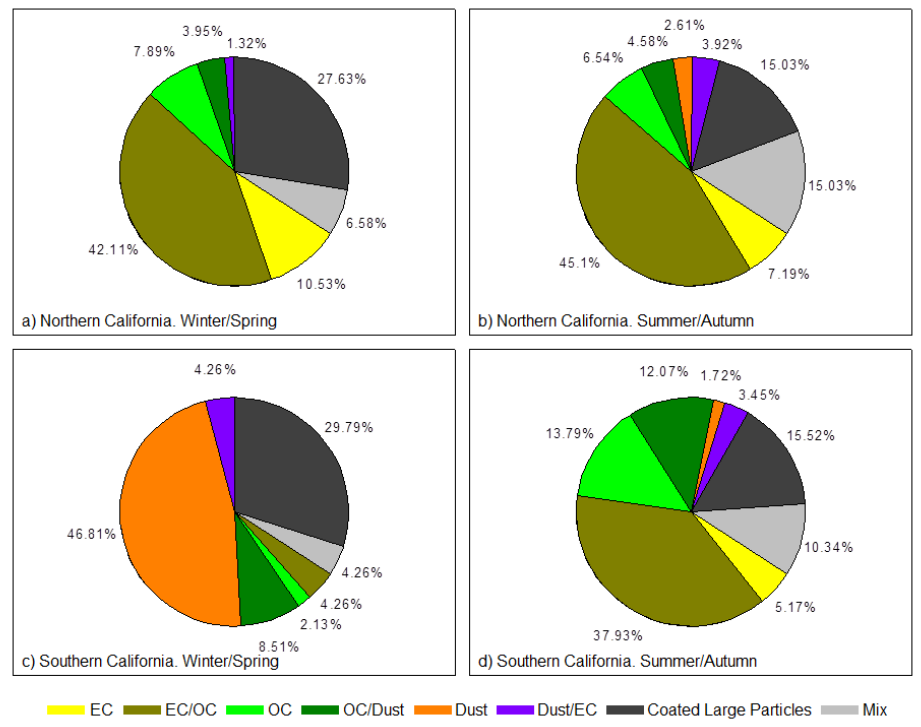
Fig. 4. Estimated number fraction of the different aerosol absorbing types by the Angstrom matrix using aerosol properties from AERONET stations in California separated by region and season: (a) Northern California – winter/spring, (b) Northern California – summer/autumn, (c) Southern California – winter/spring, and (d) Southern California – summer/autumn.